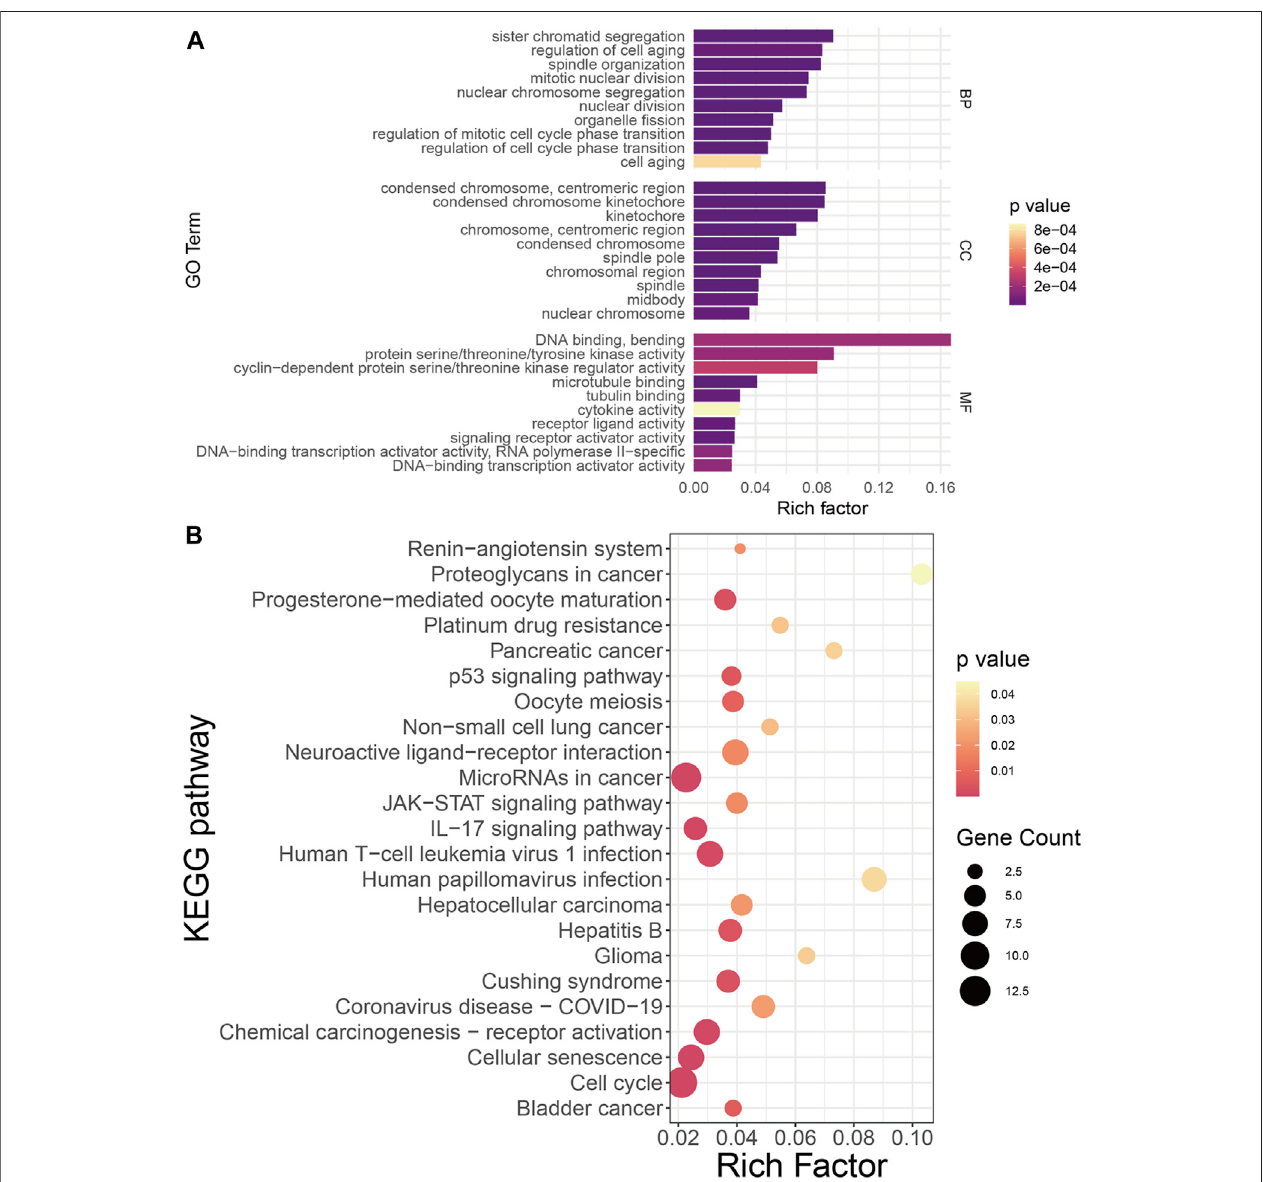
FIGURE3| FunctionalannotationofCOVID-19/NSCLCinteractionalgenes. (A) GOanalysisofCOVID-19/NSCLCinteractionalgenes. (B) KEGGpathwayanalysis of COVID-19/NSCLC interactional genes. Note: rich factor is de fi ned as the ratio of input genes that are annotated in a term to all genes that are annotated in this term. The computational formula of rich factor is as follows: Rich factor = number of input genes under this pathway term/number of all annotated genes under this pathway term. The greater the rich factor, the greater the degree of pathway enrichment.